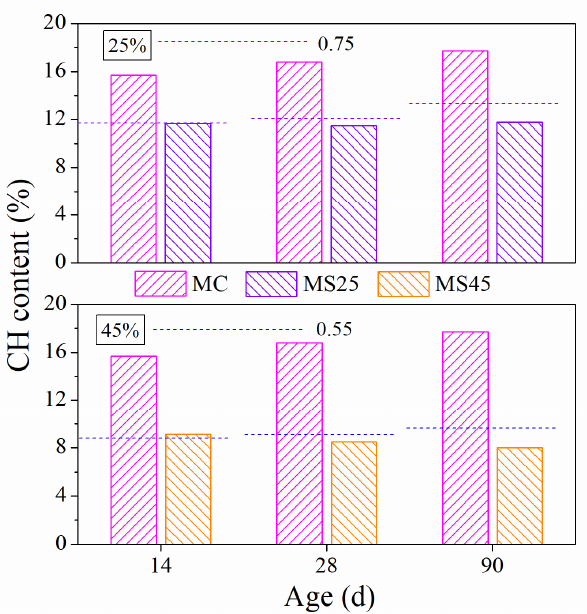
Figure 13. CH content of hardened pastes under temperature-matching curing conditions.